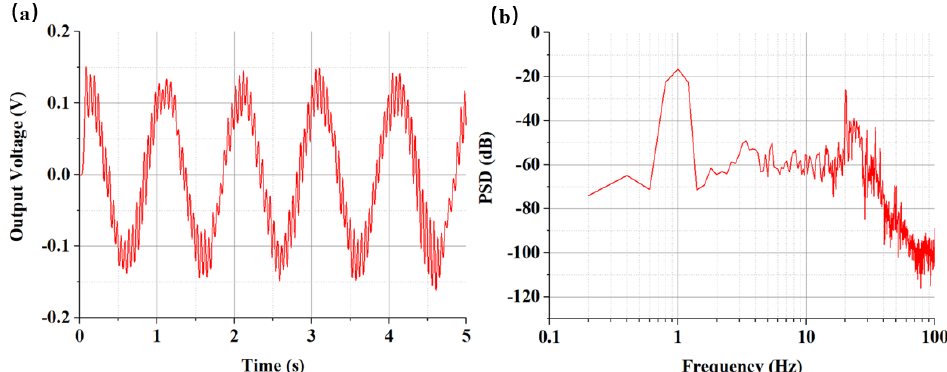
Figure 5. ( a ) The output voltage of the seismic sensor under the input velocity of 0.07 mm/s @1 Hz and with the temperature of 10 °C ( b ) The power spectrum signals of the test results of sensitivity at 1 Hz under the temperature of 10 °C.